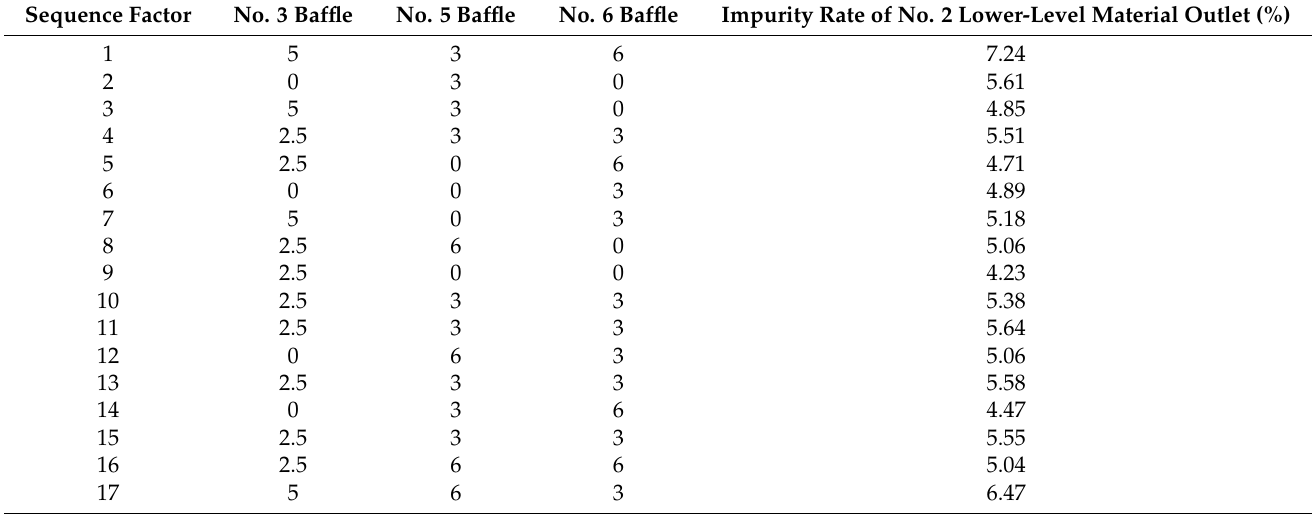
Table 7. Test results of double-layer tea winnowing machine of Lan tea material.